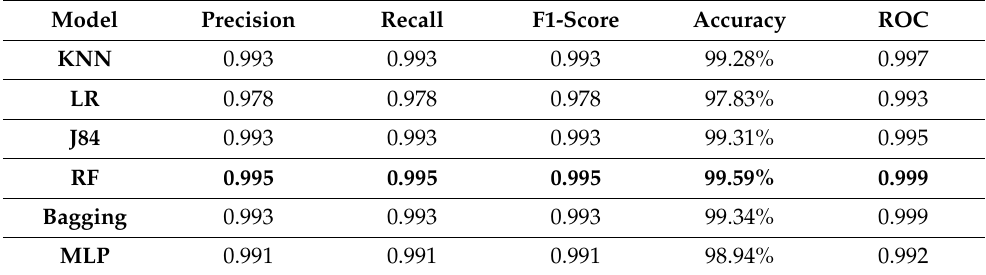
Table 7. Binary experiment results after features selection.